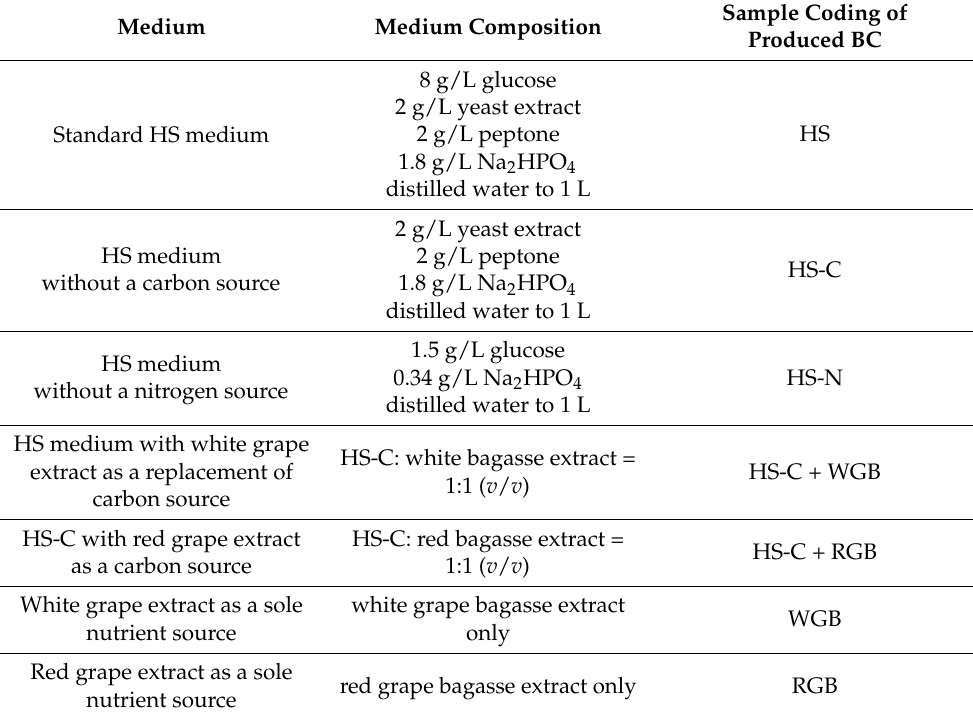
Table 1. Bacterial cellulose (BC) preparation treatments and sample coding according to the procedure.